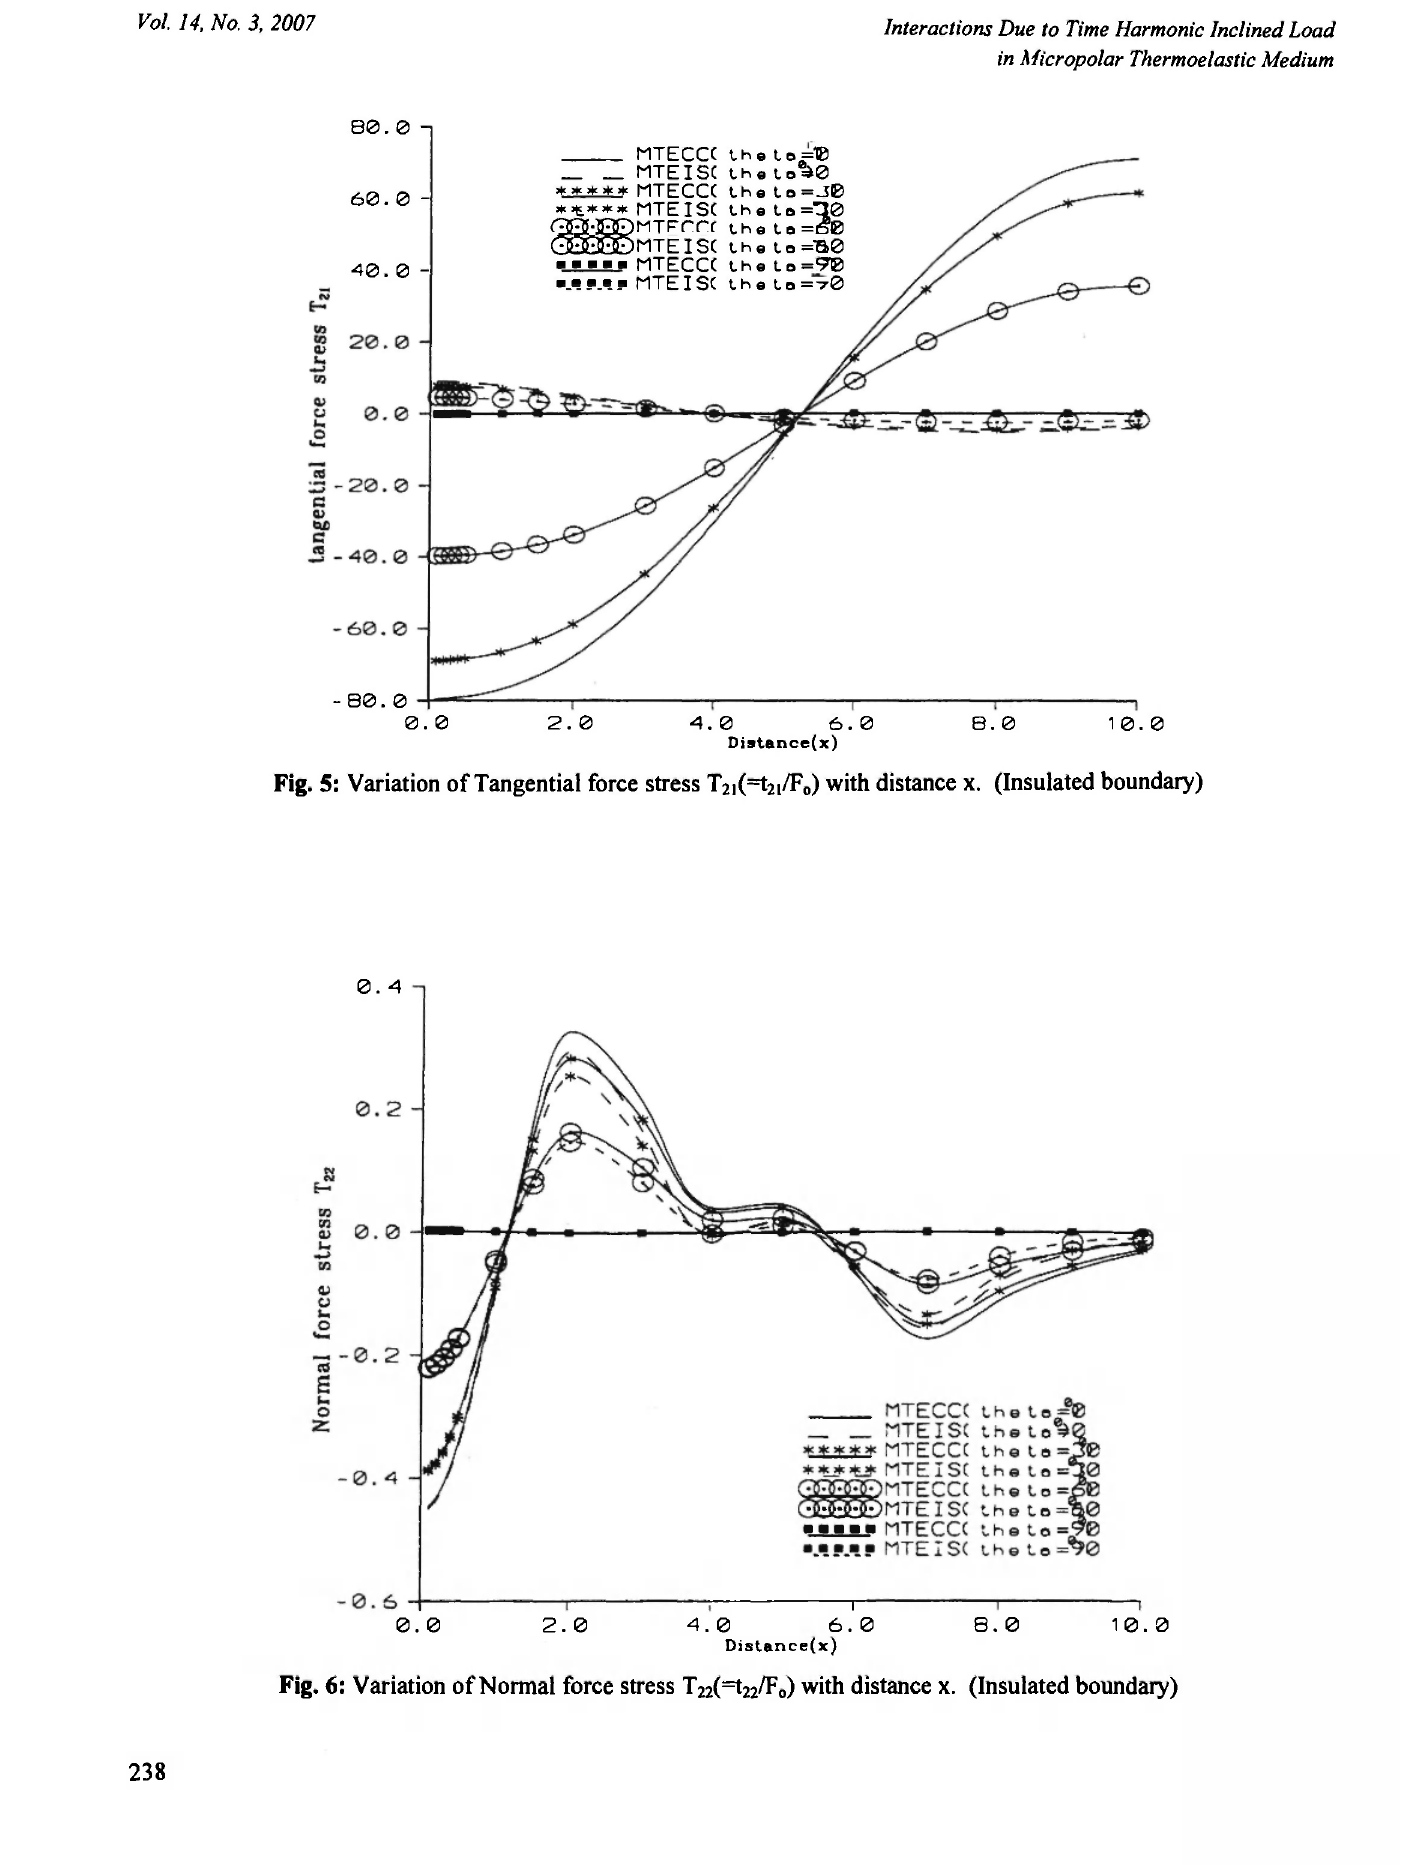
Fig. 5: Variation of Tangential force stress T 2 ](=t 2 i/Fo) with distance x. (Insulated boundary)